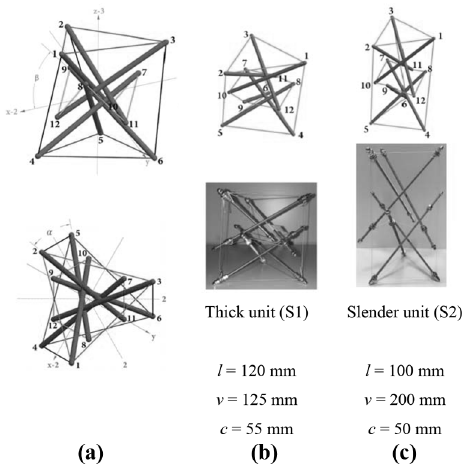
Figure 1. (a) Reference con fi guration of a class u ¼ 1 tensegrity prisms: 3D (top) and plan (bottom) views; (b and c) graphical (top) and physical (bottom) models of the analysed